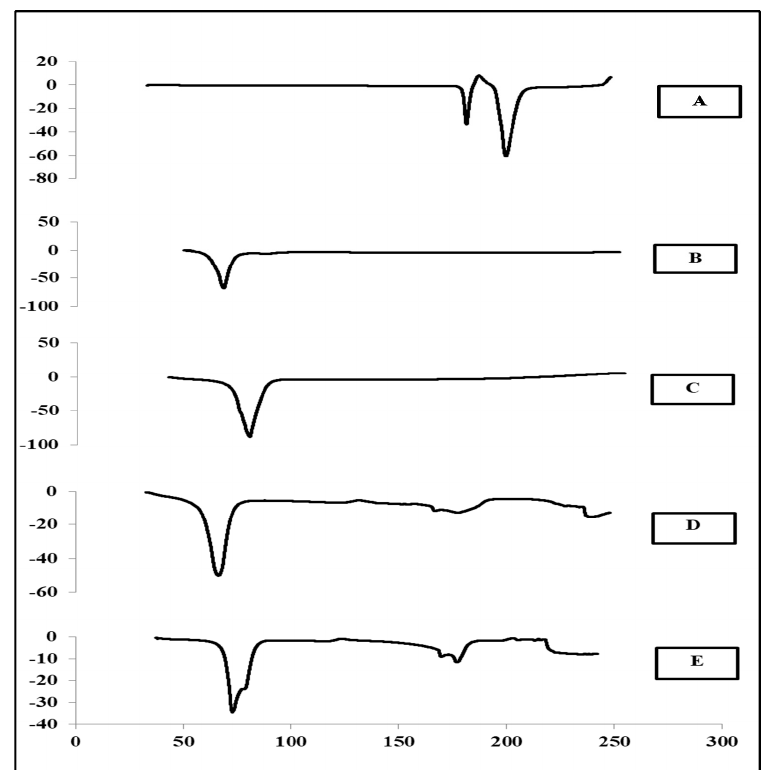
Figure 6. The thermal analysis of ( A ) pure carbamazepine, ( B ) glyceryl monostearate, ( C ) stearic acid, ( D ) solid lipid nanoparticle prepared with glyceryl monostearate, and ( E ) solid lipid nanoparticle prepared with stearic acid.